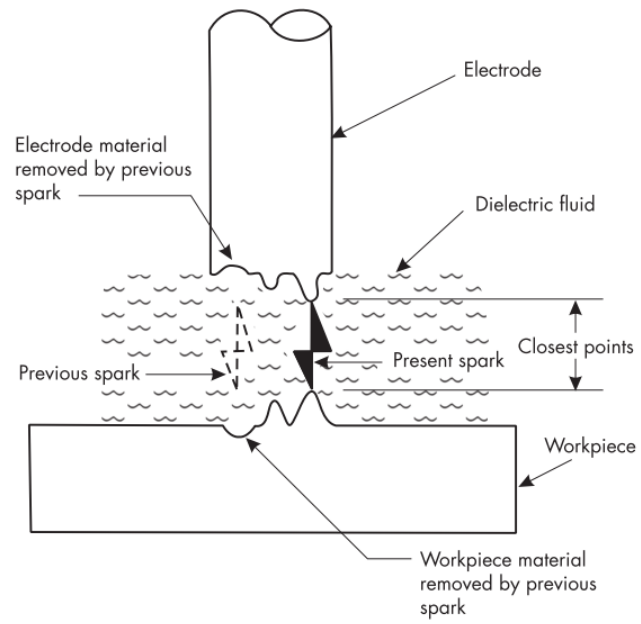
Figure 18. Schematic representation of Electrical Discharge Machining [122]. Reprinted with permission from [122]; 1983 Manufacturing Engineers.